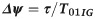
(a) Short wave heights calculated at P1, P2, and P3 (Eq 2). Gray shadings indicate the initial and peak typhoon periods, T1 and T2, respectively. (b) Infragravity-wave heights. (c) Significant wave periods (Eq 3). (d) SS wave-height-to-water-depth ratio. (e) Groupiness factor (Eq 4). (f) and (g) Cross-correlations between the wave-group envelope and IG waves at P1 and P2 (Eq 5). Time lag, τ, is converted to the phase lag of the IG waves by Δψ=τ/T01IG.